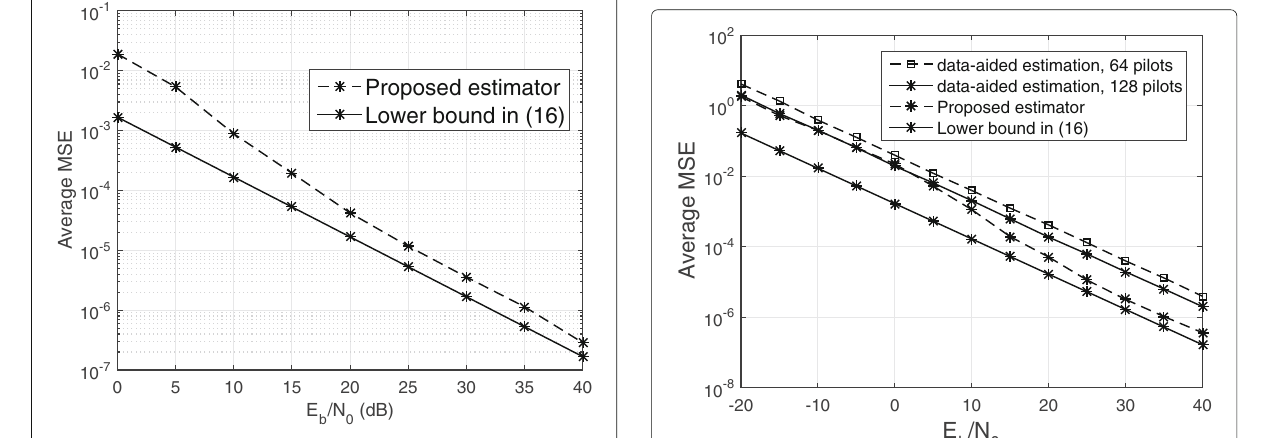
Fig. 4 MSE performance of the proposed channel estimator vs. E b / N 0 for β = 0.2, N = 128, and SIR = − 50